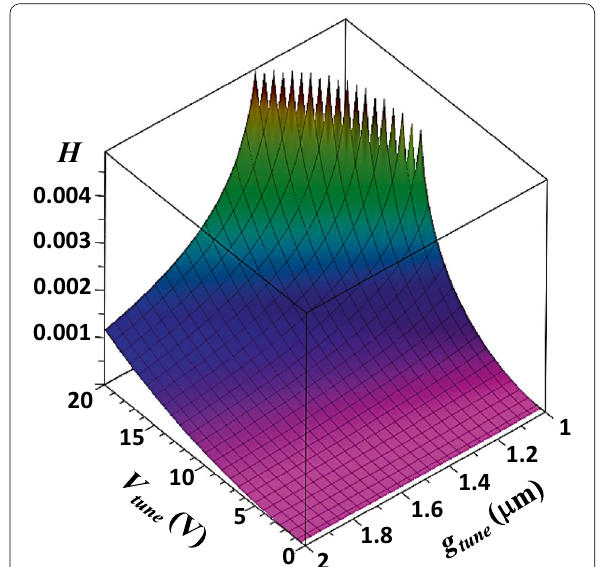
Fig. 9 3D plot of H with respect to V tune and g